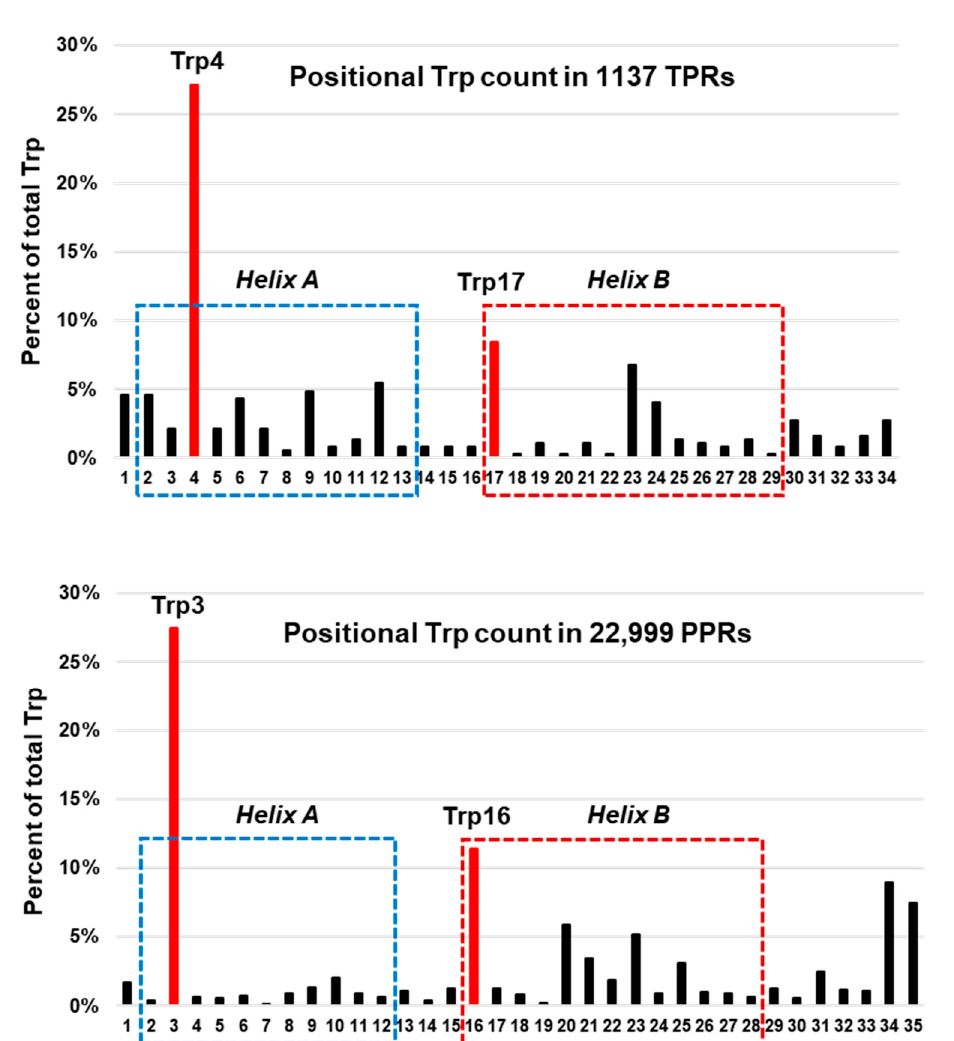
Figure 2. Near-terminal location of tryptophan (Trp) in all helical repeats. The published collections of the tetratricopeptide and pentatricopeptide repeat sequences [102,103] were visually analyzed for the location of Trp residues, and the numbers were plotted, using Excel. The two classic helices of the tetratricopeptide repeat (TPR) ( Top ) and pentatricopeptide repeat (PPR) ( Bottom ) motif are shown as Helix A and Helix B, and their amino acid position numbers are presented on the horizontal axis. The two most abundant Trp residues (Trp4 / 3 and Trp17 / 16, in Helix A and Helix B, respectively) are indicated as red bars; note that both are near the N-terminal end of the helices.